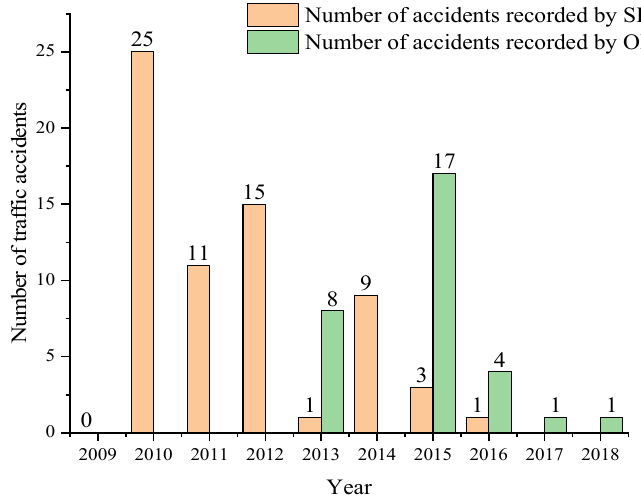
Figure 14. Number of traffic accidents per year for subcategory M3 bus type.